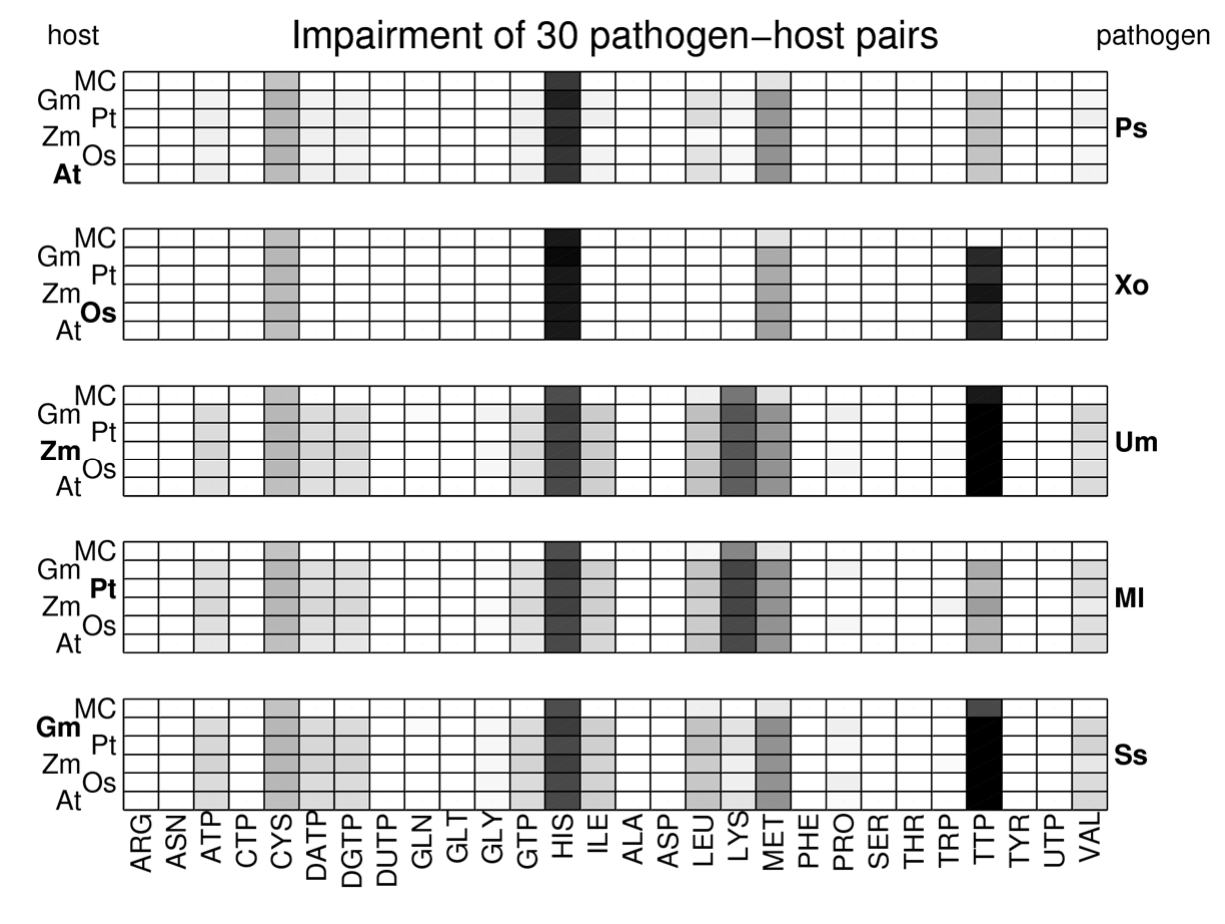
Figure 4. Relative impairment scores for essential biomass precursors for all investigated host-pathogen pairs. Impairment scores are indicated by grey-scale in a logarithmic scale. White squares indicate an impairment score of less than 0.01, black squares a score of 1. The network pairs are grouped by pathogens so that each panel displays the effect of one particular pathogen on each of the five plant networks and the complete MetaCyc network (MC). Native plant-pathogen pairs are highlighted in bold